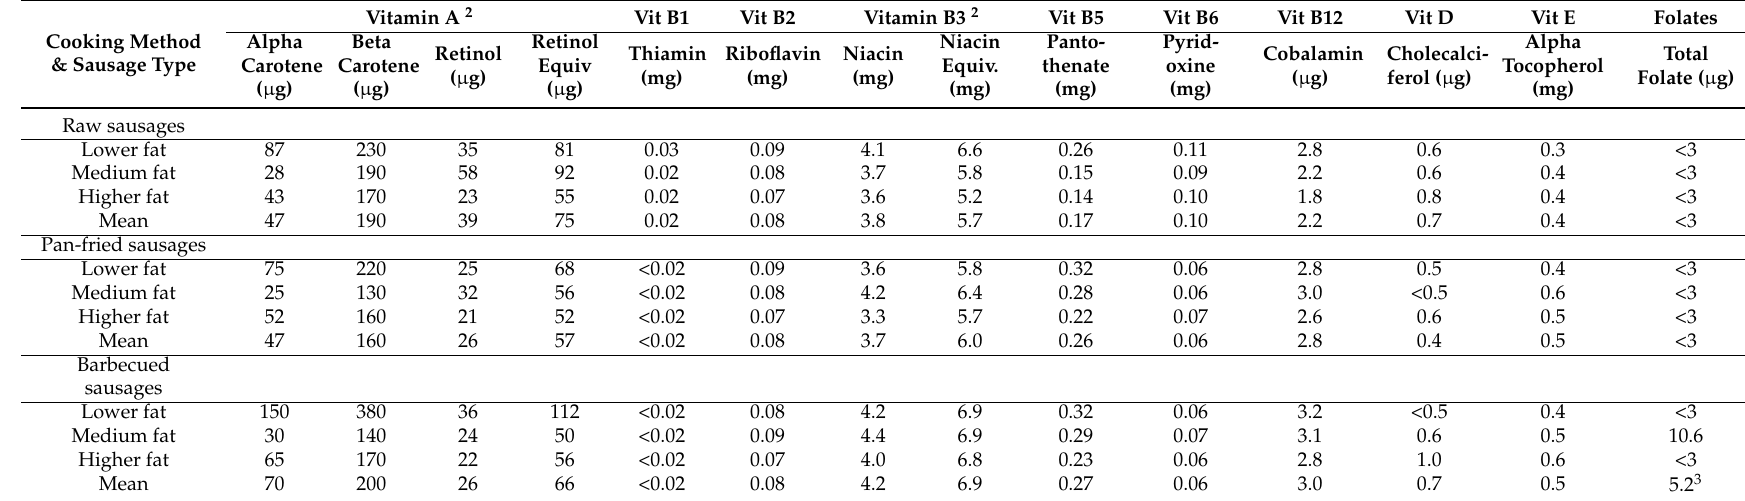
Table 5. Vitamin (“Vit”) content of composite samples of beef sausages 1 grouped according to fat content; raw, pan-fried without oil and barbecued. All values are expressed per 100 g edible